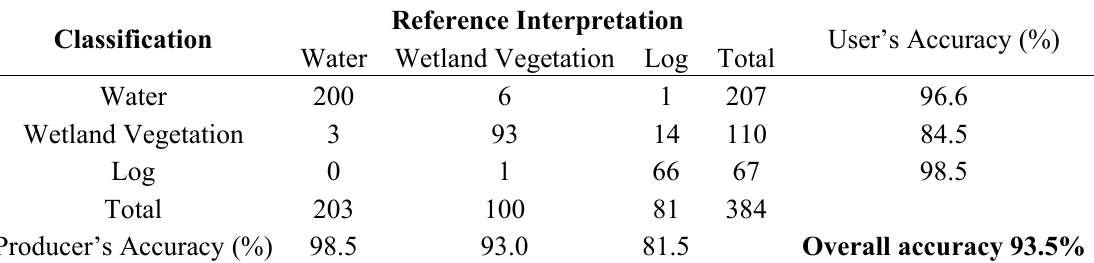
Table 4. Error matrix for within wetland habitat feature